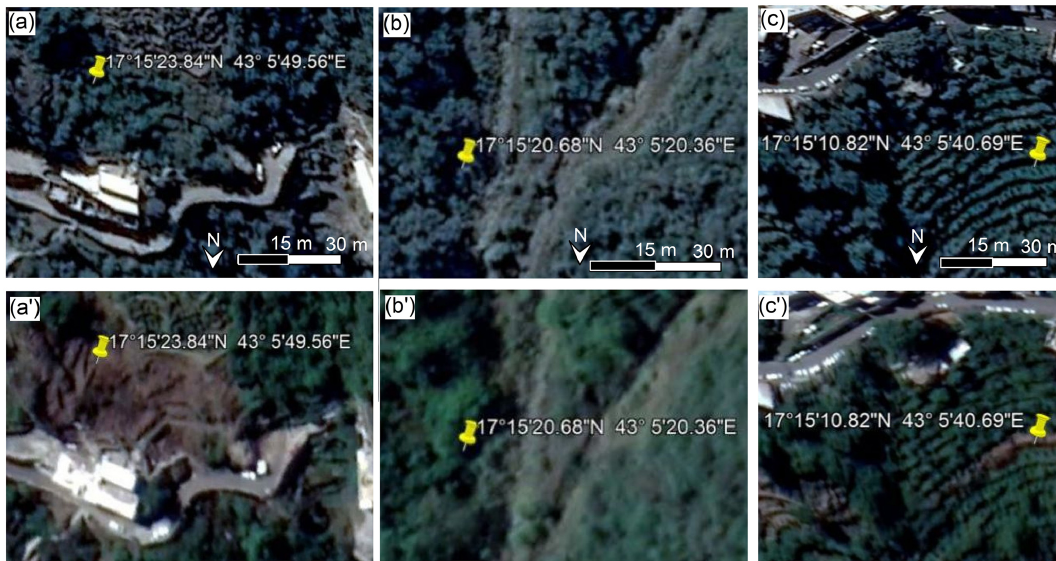
Figure 9. Demonstration of the prediction result using Google Earth imagery (map data: Google, DigitalGlobe, and CNES/Airbus) for the storm that occurred on 14 February 2017. (a) Area that witnessed a landslide that was predicted (true positive). (b) Area that did not witness landslide but was predicted (false positive). (c) Area predicted as stable but witnessed landslide (false